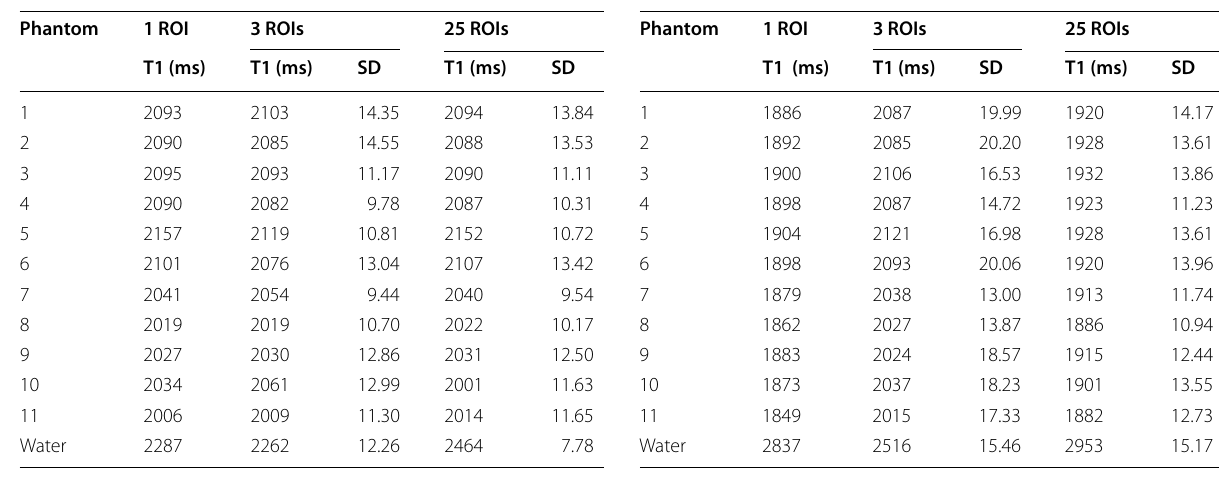
Table 7 T1 values of all agar gel phantoms at